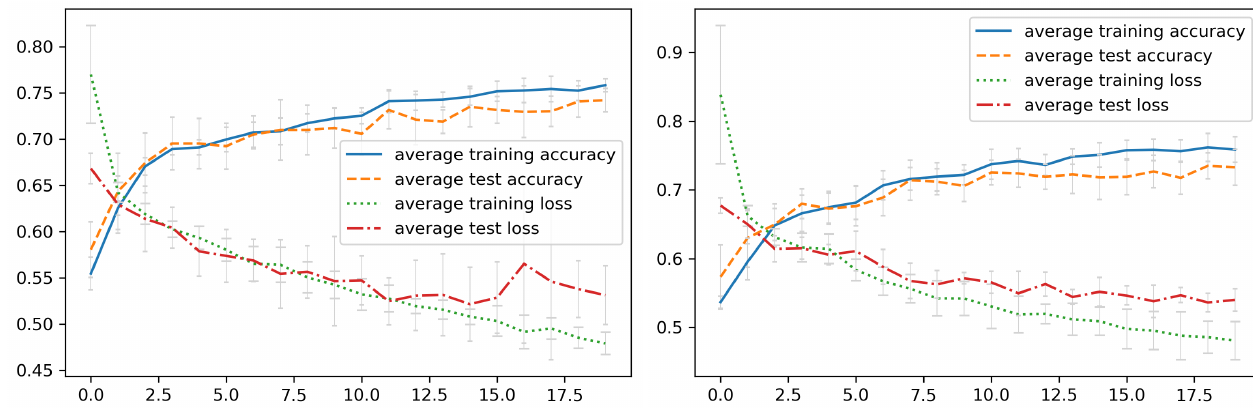
Figure 14. Summary of average results for 20 iterations. Class 0 vs. I. Model: the LeNet model from Figure 5 was applied. Cross-validation 5. Accuracy for 20 iterations of neural network training and corresponding cross-entropy loss.